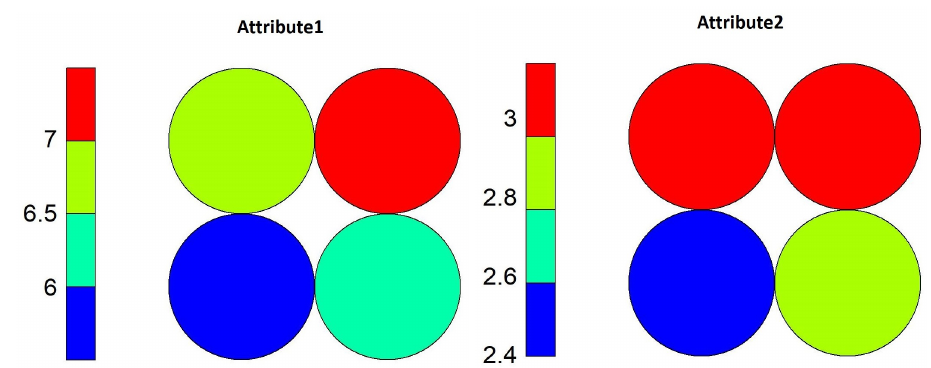
Figure 6. Variable heatmap—synthetic database.